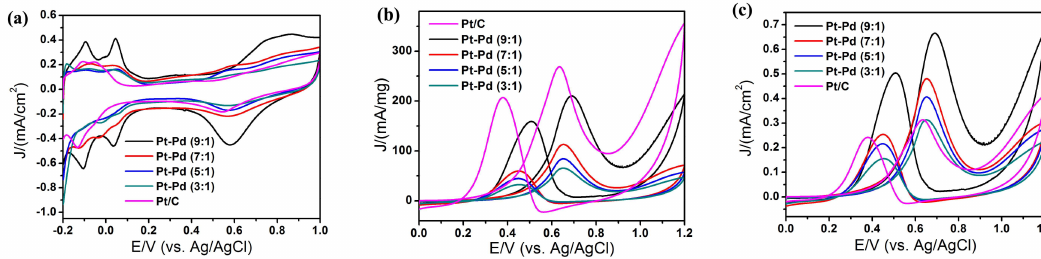
Figure 6. CV curves of Pt–Pd nanoparticles prepared by adding precursors with different ratios and commercial Pt/C: ( a ) in 0.5 M H 2 SO 4 solution; ( b ) in 1.0 M methanol + 0.5 M H 2 SO 4 solution, mass